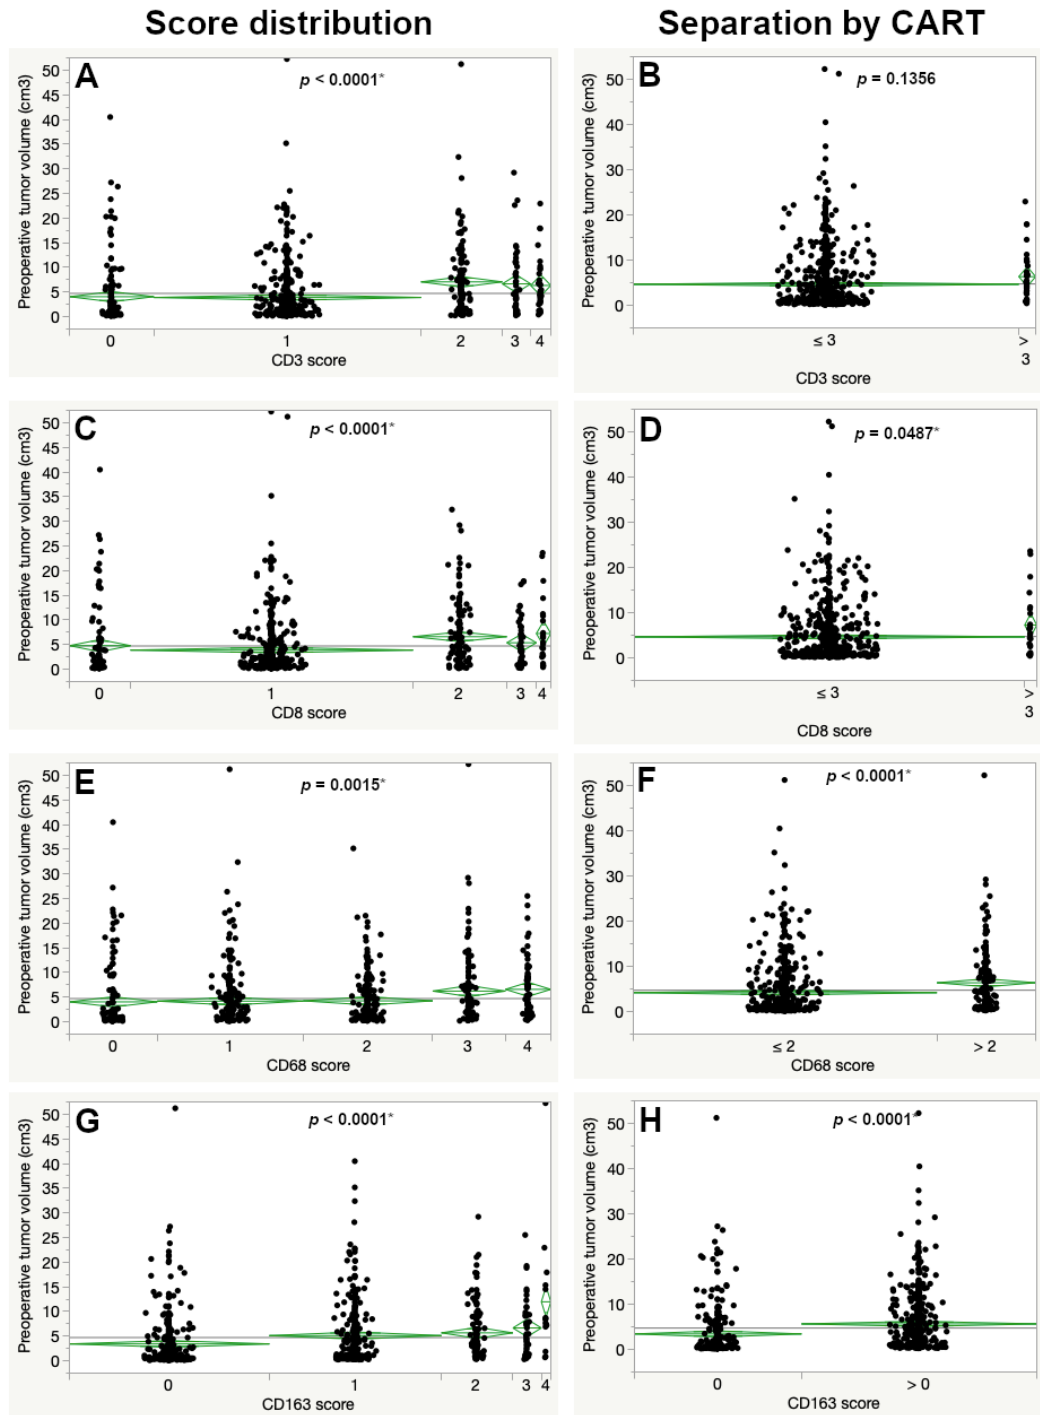
Figure 3. Differences in preoperative tumor volume according to the immunohistochemical expression across the complete immunohistochemistry score (left images) and after determining the CART-specific cut-off (right images) for CD3 ( A , B ), CD8 ( C , D ), CD68 ( E , F ) and CD163 ( G , H ). Significantly larger preoperative tumor volumes were seen with increased expression of each marker (ANOVA; an asterisk (*) marks statistically significant results).